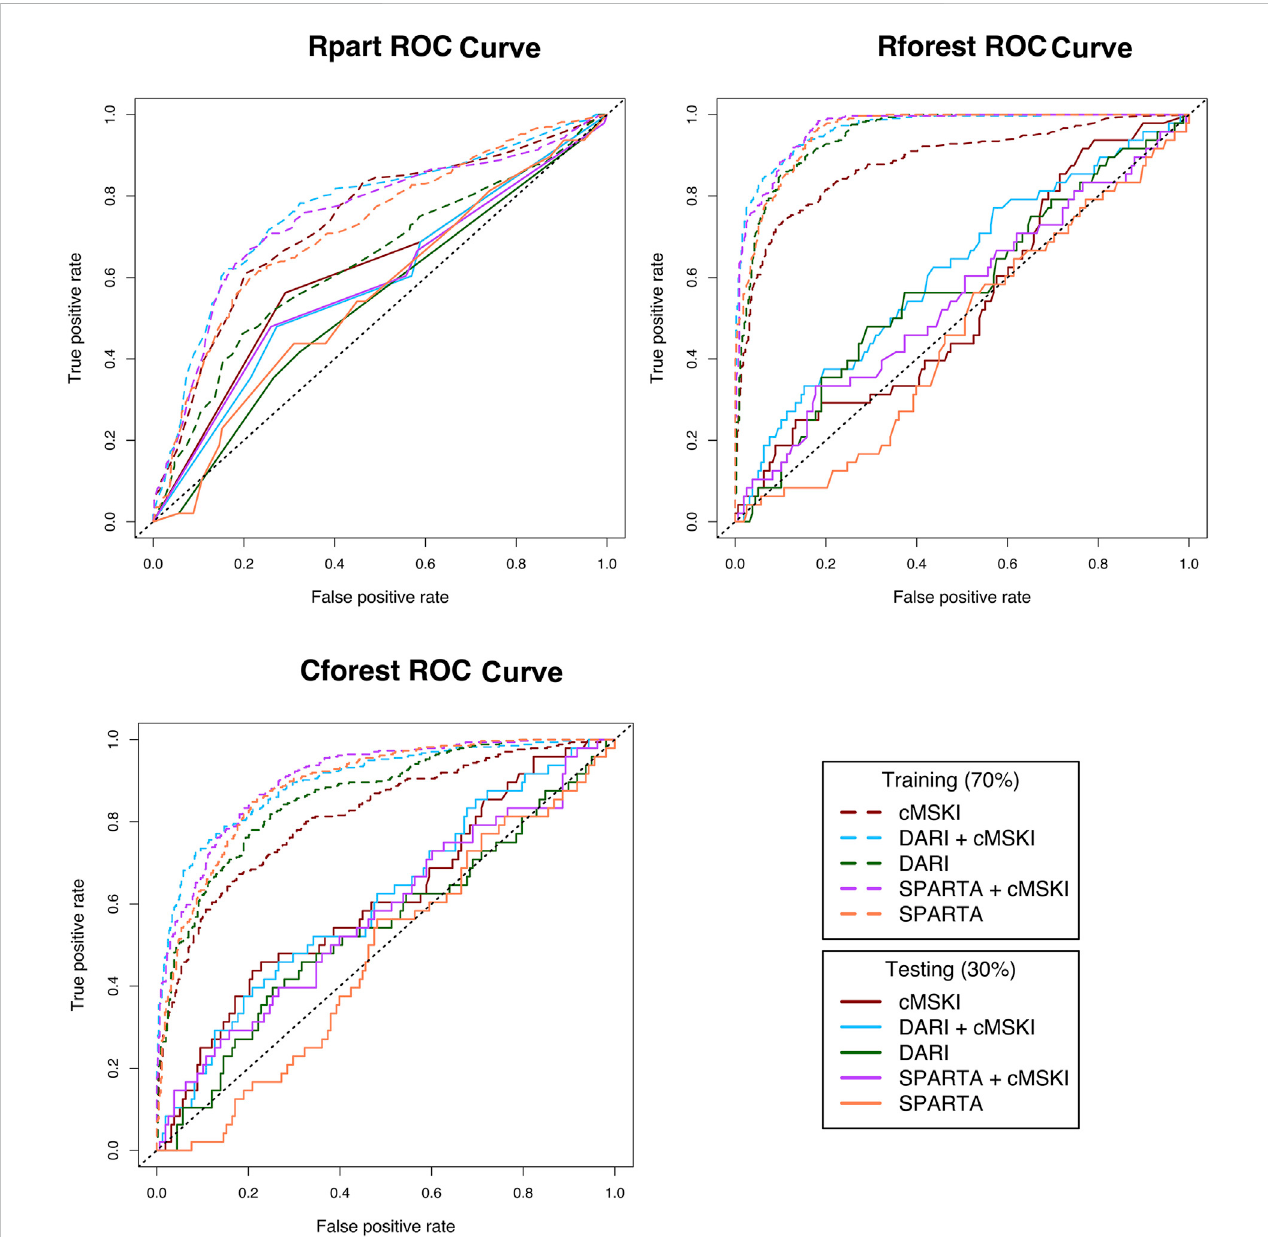
FIGURE 2 Receiver operating characteristic (ROC) curves for Rpart, Rforest, and Cforest algorthiums training and testing data; Rpart, Cforest, and Rforest algorithums weretrained andtested on thedifferentdata sets: 1)Commonmuskuloskeltal injury (cMSKI), 2)DARI ™ + cMSKI, 3)DARI ™ ,4) SPARTA ™ + cMSKI, and 5)SPARTA ™ ; Area under the curve (AUC) is calculated for each ROC curve in Table